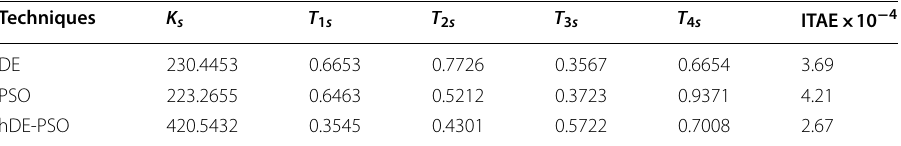
Table 1 Optimized controller parameters